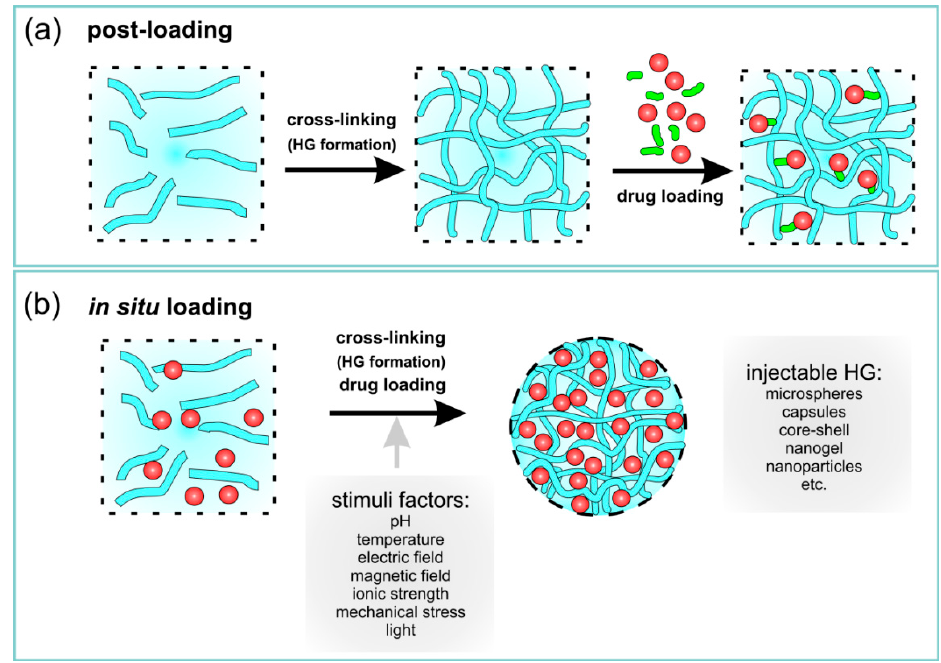
Figure 5. Schematic representation of drug loading in a HG network using ( a ) post-loading and ( b ) in situ loading mechanisms.